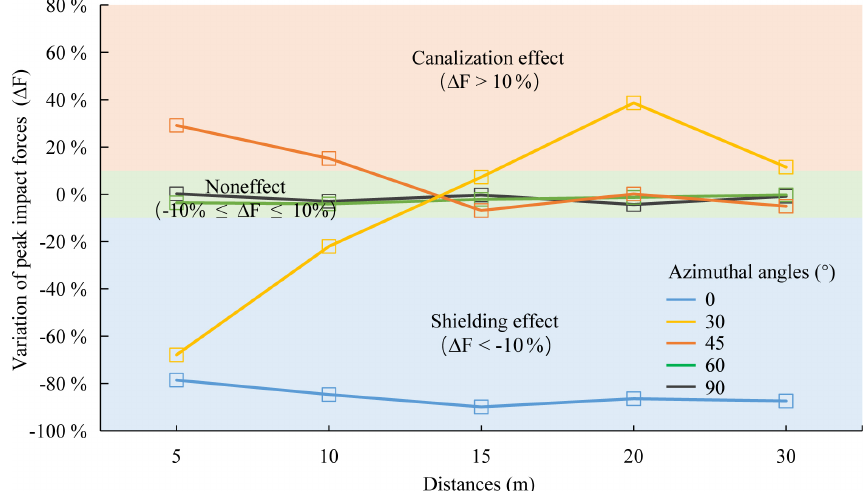
Figure 10. Peak impact forces change with the surroundings’ distances under the influence of azimuth angles in the scenarios of the orienta- tion of 90 ◦ and the opening scale of 0.4 (Or90-Op0.4- Ax - Dx ).